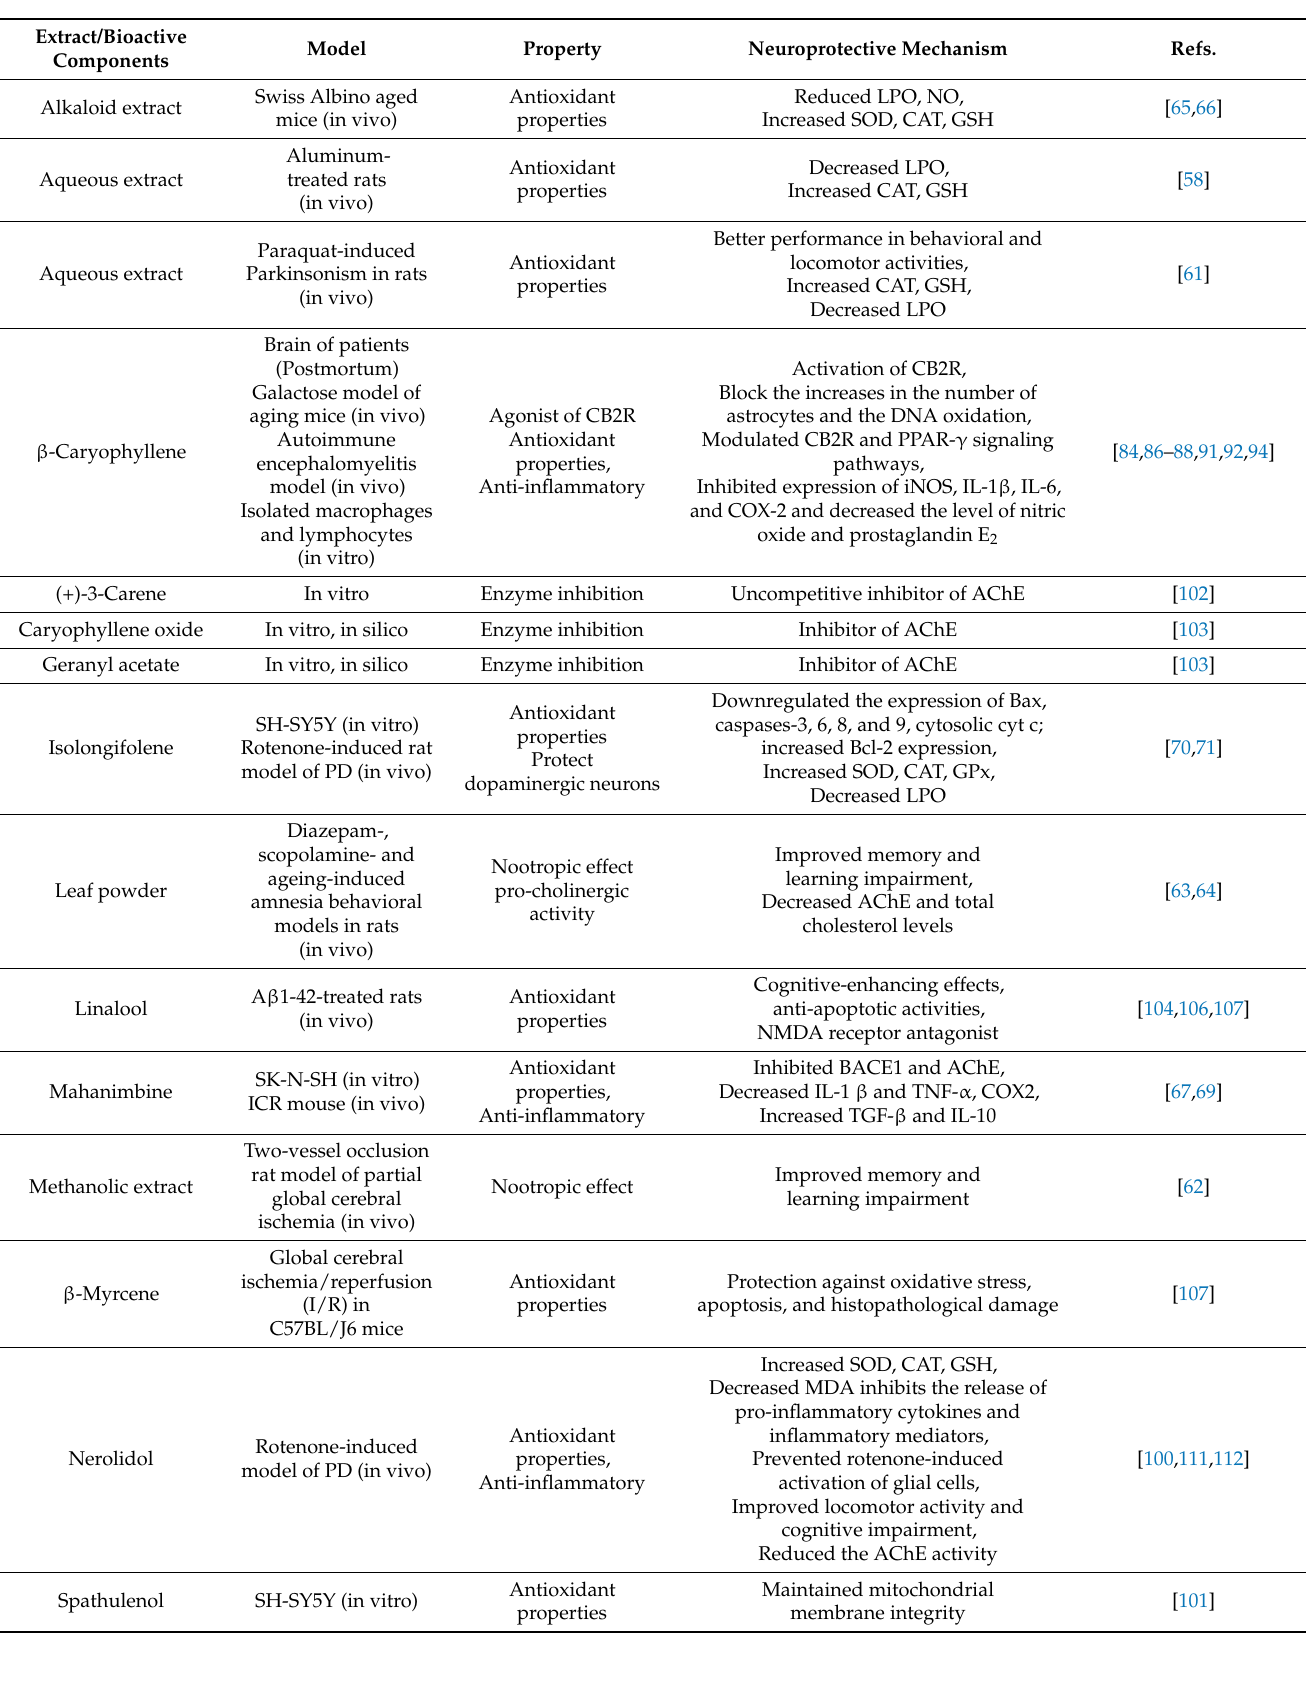
Table 1. Mechanism of action of different extracts of Murraya koeingii leaves and their bioactive components in ameliorating symptoms of